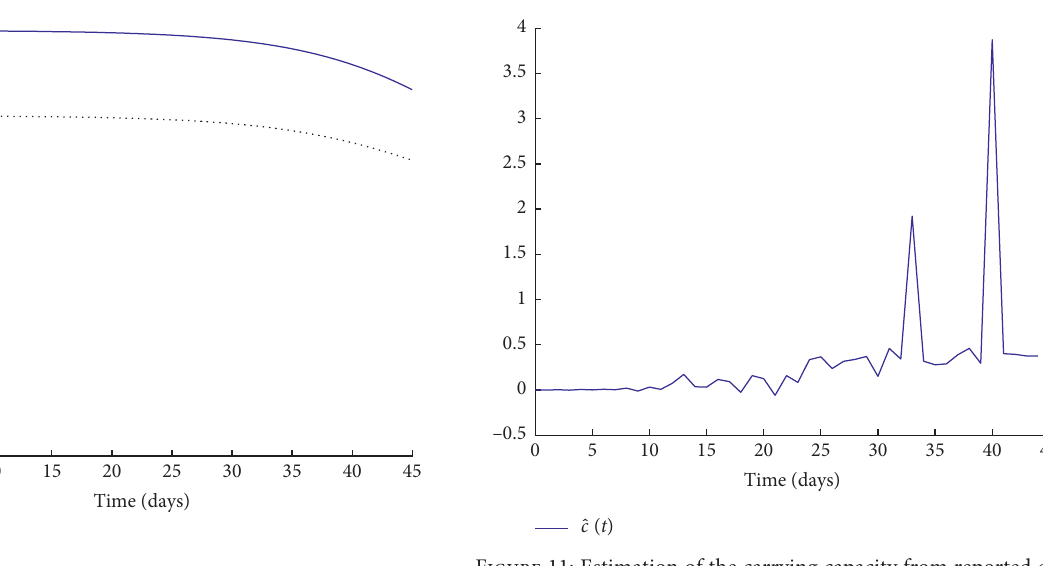
Figure 11: Estimation of the carrying capacity from reported data (Italy).